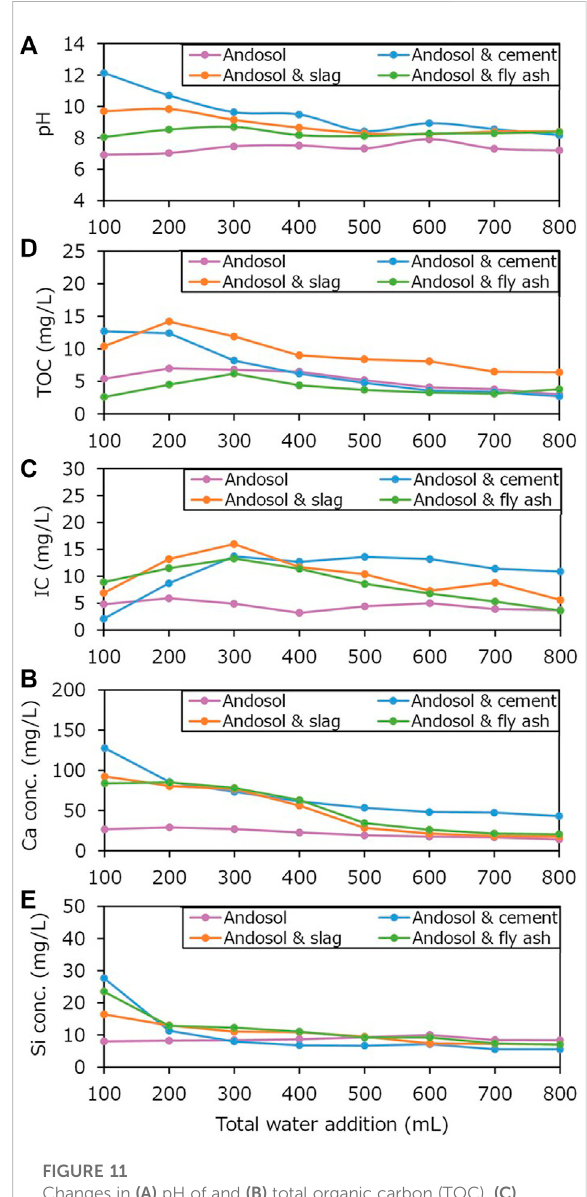
FIGURE 11 Changes in (A) pH of and (B) total organic carbon (TOC), (C) inorganic carbon (IC), and (D) Ca and (E) Si concentrations in the ef fl uentsinthe fl ow-throughtypeexperiments,withouttheclosed box, as a function of total water